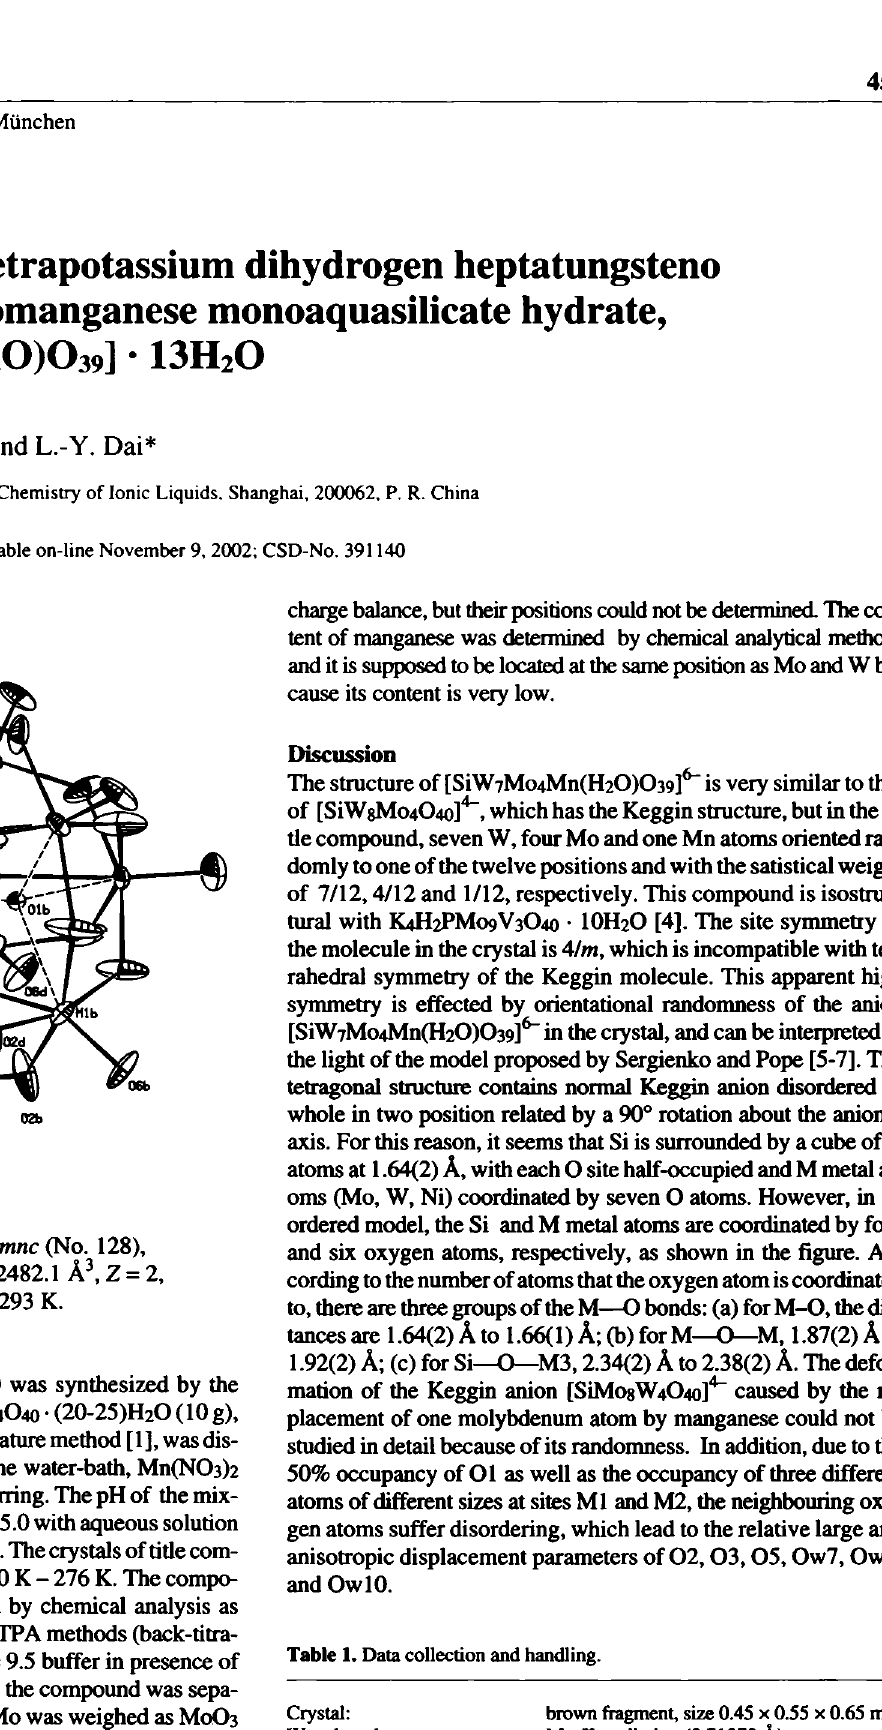
Table 1. Data collection and